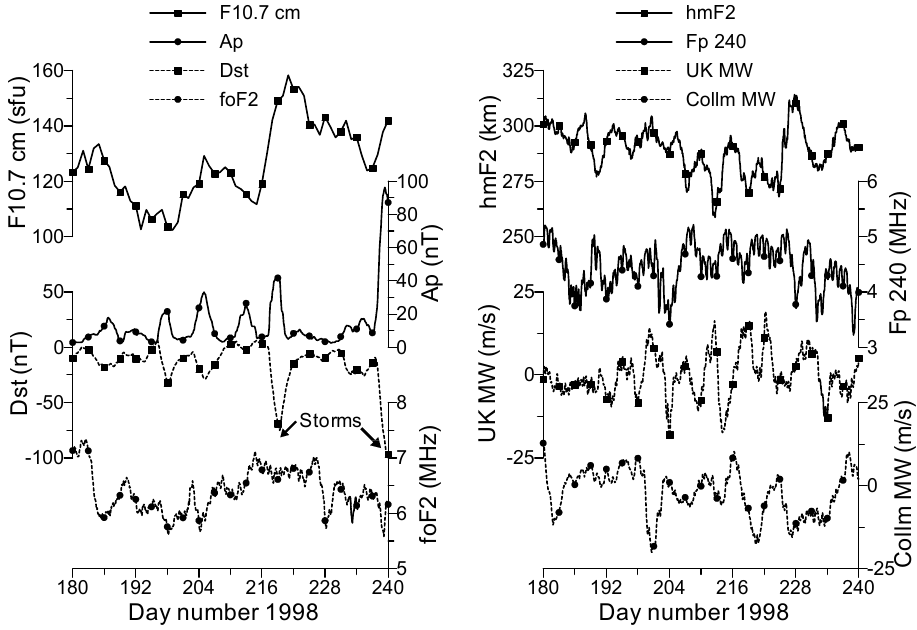
Fig. 6. Time development of the 51-h running mean values of each time series in the time interval from 1 June to 31 August 1998.